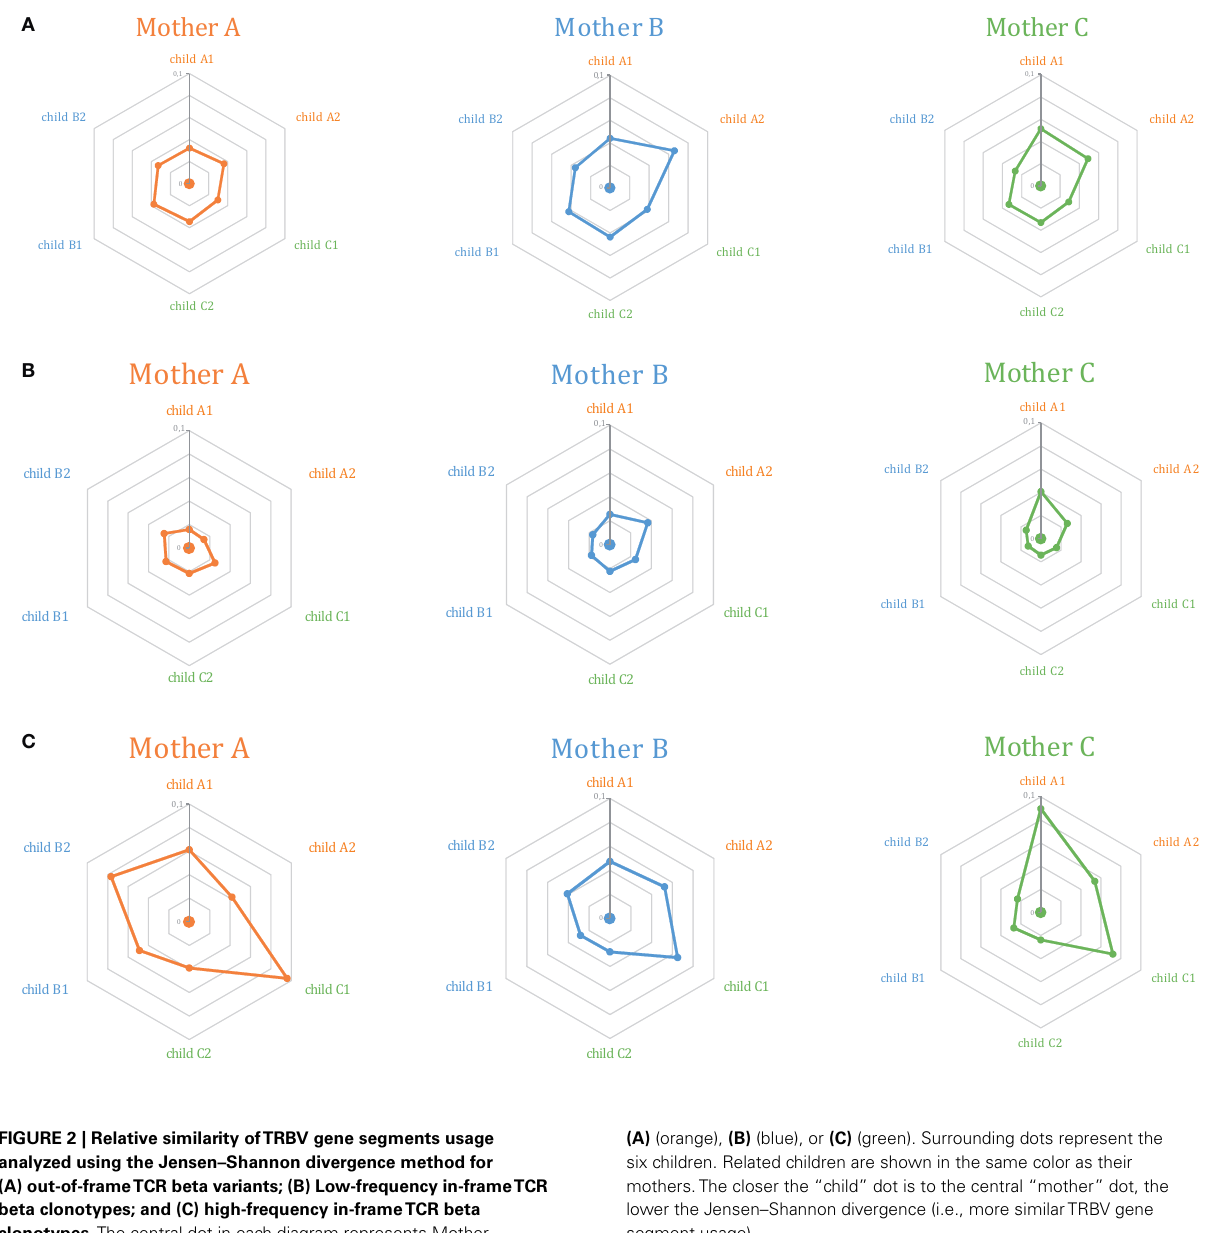
(A) (orange), (B) (blue), or (C) (green). Surrounding dots represent the six children. Related children are shown in the same color as their mothers.The closer the “child” dot is to the central “mother” dot, the lower the Jensen–Shannon divergence (i.e., more similarTRBV gene segment